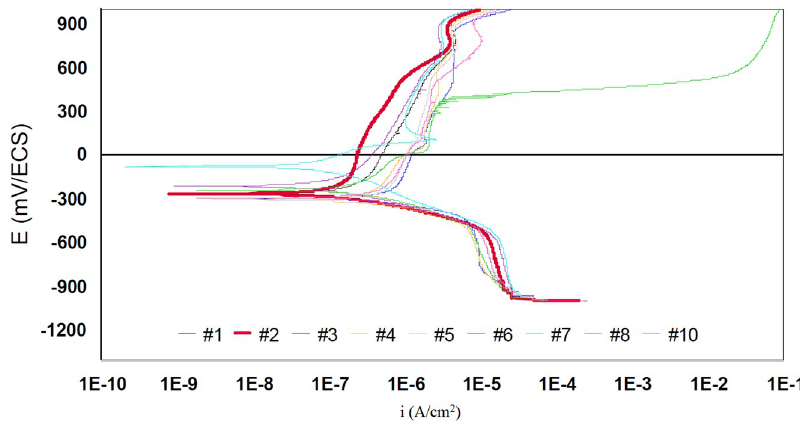
Figure 5. Semi-logarithmic potentiodynamic curves for all grades.